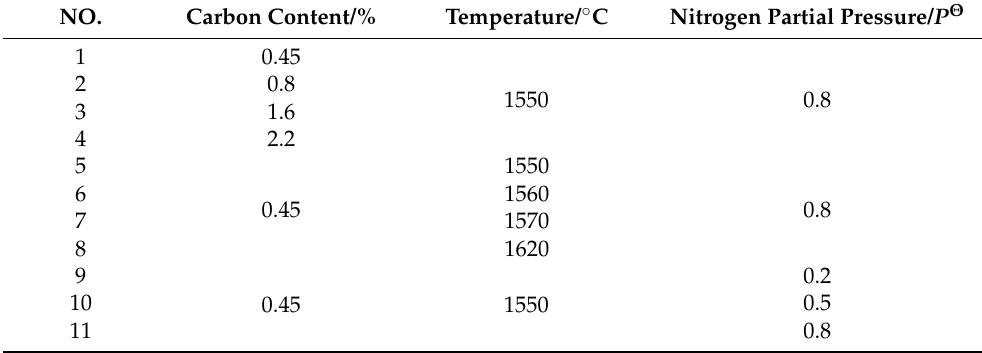
Table 2. Experimental plan for scrap melting period.